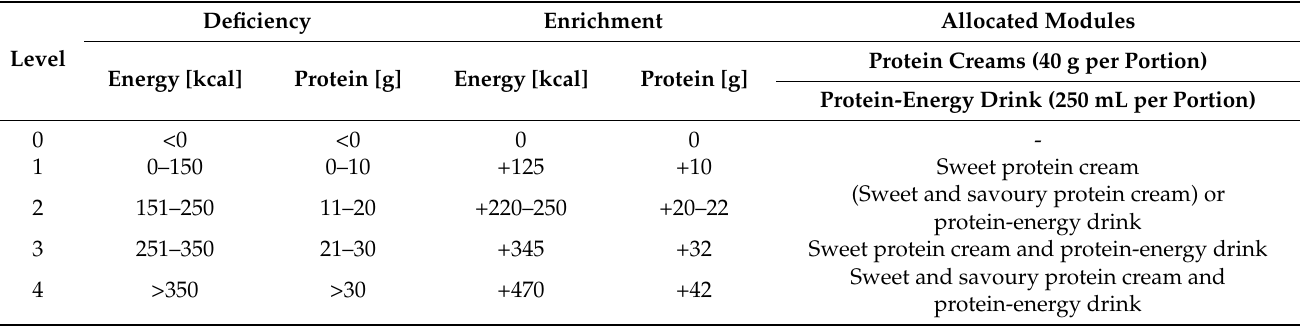
Table 1. Energy and protein deficiency, enrichment modules and their energy and protein content in 5 levels of enrichment.